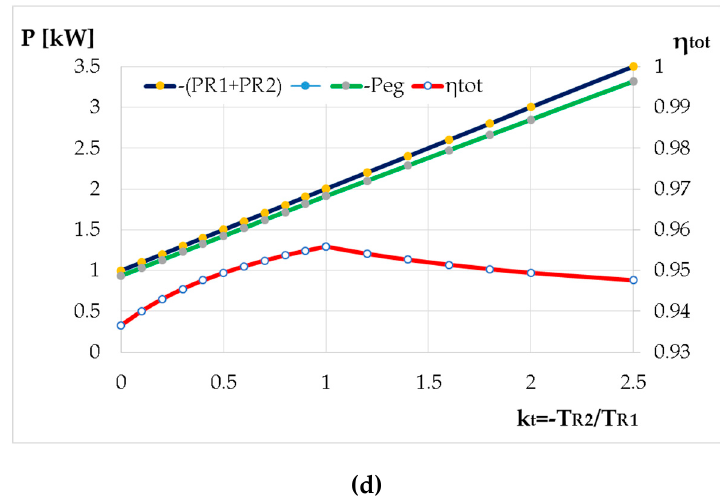
Figure 5. The influence of the k t ratio on the speed increaser efficiency and on the output power P eg : ( a ) the T R 2 torque and η tot efficiency variations; ( b ) the η tot efficiency variation around the maximum value for different values of the i aR 1 -eg ratio; ( c ) the power P eg variation; ( d ) the powers and efficiency variations for k t < 2.5.